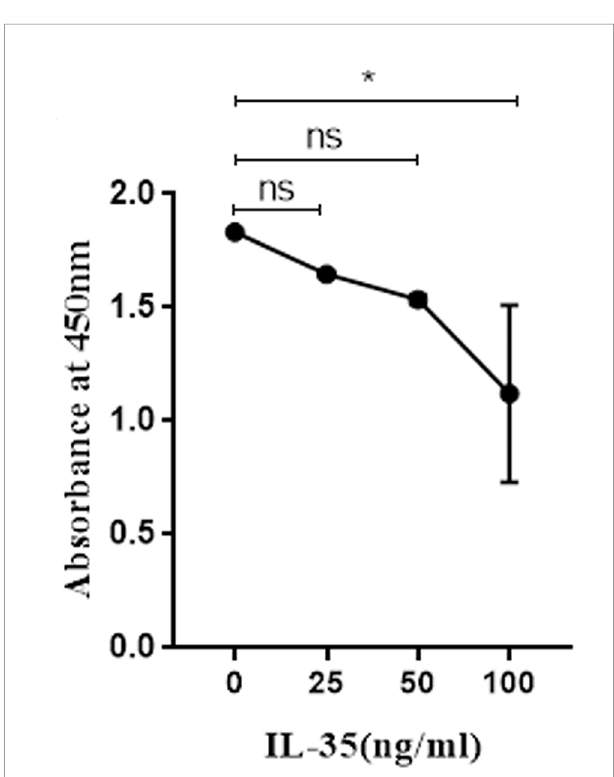
FIGURE 2 | The effects of IL-35 at different concentration (0, 25, 50 and 100 ng/ ml) on the viability of osteoclasts. Mean ± SD, n = 3. *P < 0.05, ns, no signi fi